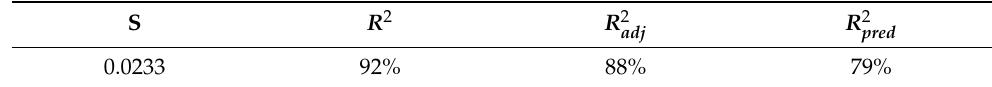
Table 4. Model summary of the second model.